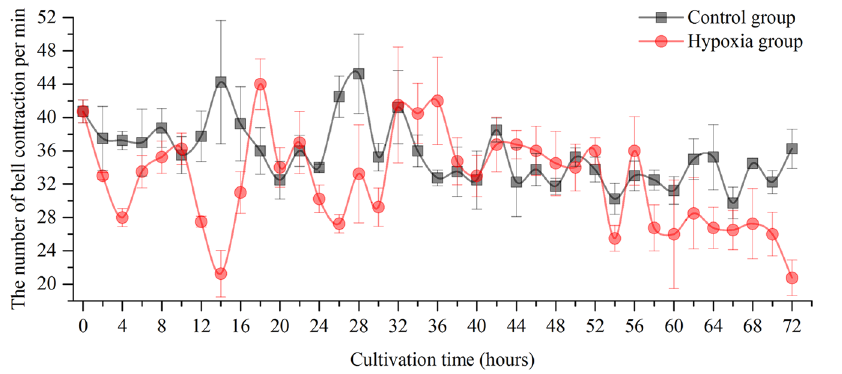
Figure 2. The variation of bell contraction number per minute in medusa.